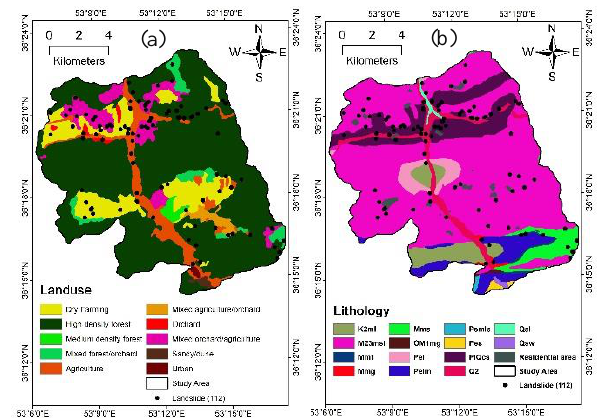
Figure 1. (a) Landuse and (b) Lithology maps of the study